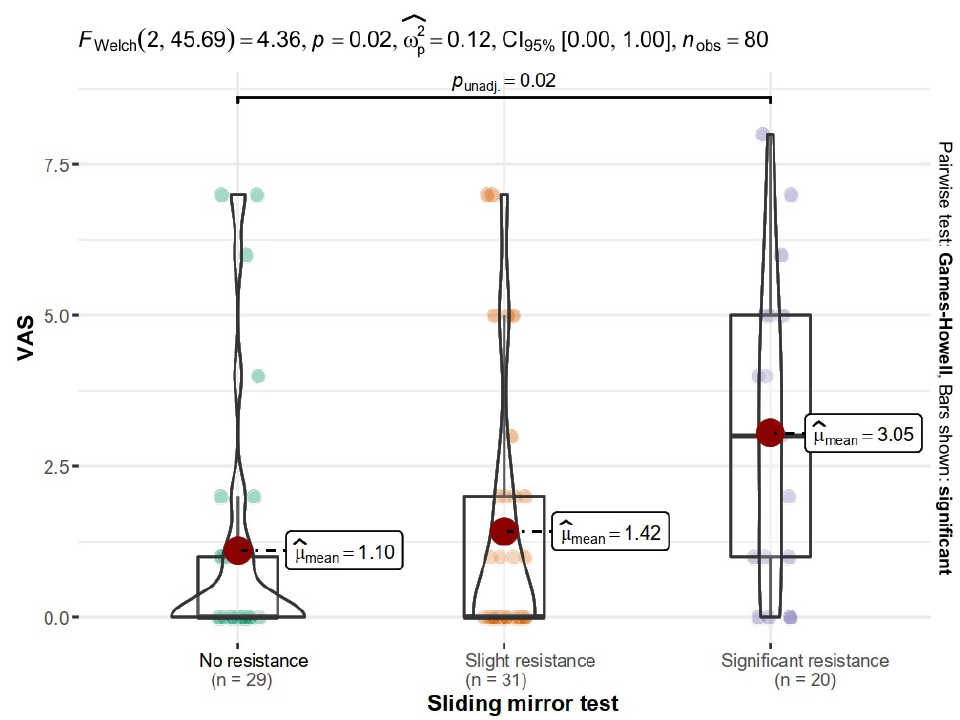
Figure 2. Relationship between VAS and the score of sliding mirror test.